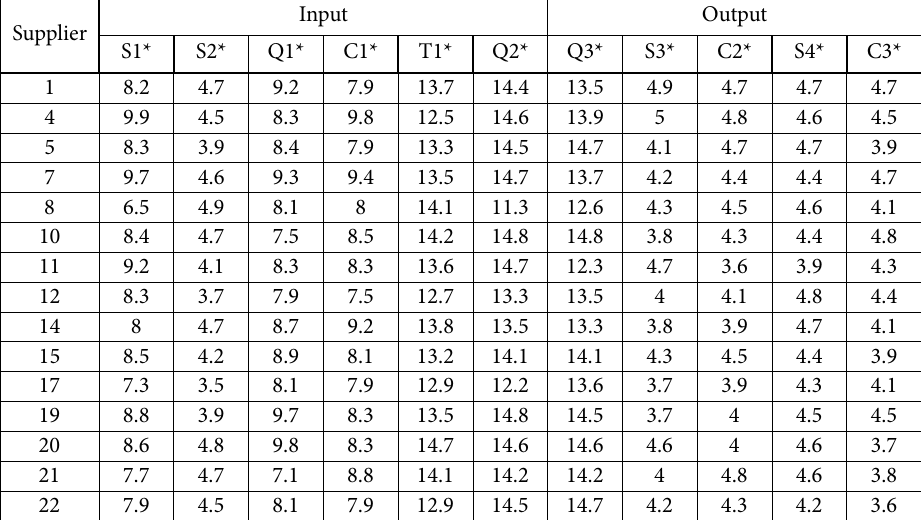
Table 23. Original inputs and outputs data for oil injection